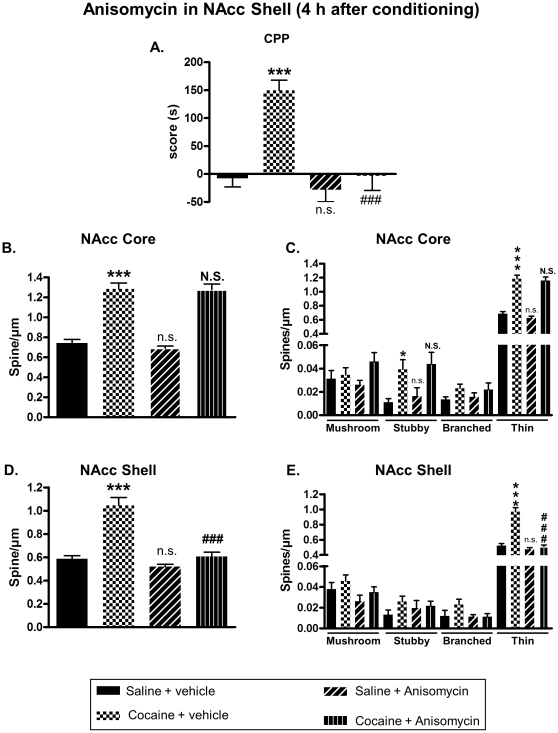
Anisomycin injection in the shell 4 hours after cocaine conditioning blocks cocaine-induced CPP and neuroplasticity in the NAcc shell.CPP was induced in adult rats with saline or cocaine at 20 mg/kg. Four hours after each afternoon conditioning session, rats received intra-shell infusion of anisomycin or vehicle. Just after the test, brains were processed for DeS analysis. CPP scores were expressed as the means ± S.E.M. (A) (Two-way ANOVA, Fcocaine(1,31) = 19.55, p<0.001; Fanisomycin(1,31) = 17.75 , p<0.001; Fcocaine × anisomycin = 10.39, p<0.01). Total DeS density was expressed as spines/µm (mean ± S.E.M.) in MSN from the NAcc core (B) (Two-way ANOVA, Fcocaine(1,31) = 147.6, p<0.001; Fanisomycin(1,31) = 0.4409, p = 0.511 ; Fcocaine × anisomycin = 0.2943, p = 0.591) and shell (D) (Two-way ANOVA, Fcocaine(1,31) = 45.27, p<0.001; Fanisomycin(1,31) = 38.87, p<0.001; Fcocaine × anisomycin = 21, p<0.001). Density of mushroom, stubby, branched or thin spines was expressed as spines/µm (mean ± S.E.M.) in MSN from the NAcc core (C) (Two-way ANOVA mushroom, Fcocaine(1,32) = 3.326, p = 0.077; Fanisomycin(1,31) = 0.218, p = 0.643; Fcocaine × anisomycin = 1.722, p = 0.199; Two-way ANOVA stubby, Fcocaine(1,31) = 14.07, p<0.001; Fanisomycin(1,31) = 0.421, p = 0.52; Fcocaine × anisomycin = 0.001, p = 0.966; Two-way ANOVA branched, Fcocaine(1,31) = 4.068, p = 0.052; Fanisomycin(1,31) = 0.023, p = 0.879; Fcocaine × anisomycin = 0.169, p = 0.683; Two-way ANOVA thin, Fcocaine(1,31) = 154.2, p<0.001; Fanisomycin(1,31) = 1.127, p = 0.296; Fcocaine × anisomycin = 0.164, p = 0.687) and shell (E) (Two-way ANOVA mushroom, Fcocaine(1,32) = 1.803, p = 0.189; Fanisomycin(1,31) = 3.207, p = 0.083; Fcocaine × anisomycin = 0.008, p = 0.926; Two-way ANOVA stubby, Fcocaine(1,31) = 1.902, p = 0.177; Fanisomycin(1,31) = 0.036, p = 0.849; Fcocaine × anisomycin = 0.964, p = 0.336; Two-way ANOVA branched, Fcocaine(1,31) = 1.584, p = 0.217; Fanisomycin(1,31) = 2.03, p = 0.164; Fcocaine × anisomycin = 1.592, p = 0.216; Two-way ANOVA thin, Fcocaine(1,31) = 56.29, p<0.001; Fanisomycin(1,31) = 60.74, p<0.001; Fcocaine × anisomycin = 38.69, p<0.001). * p<0.05; *** p<0.001; n.s. (not significant) vs Saline + vehicle group; ## p<0.01; ### p<0.001; N.S. (not significant) vs Cocaine + vehicle group, Bonferroni post-hoc test, n = 8 to 10 animals/group.